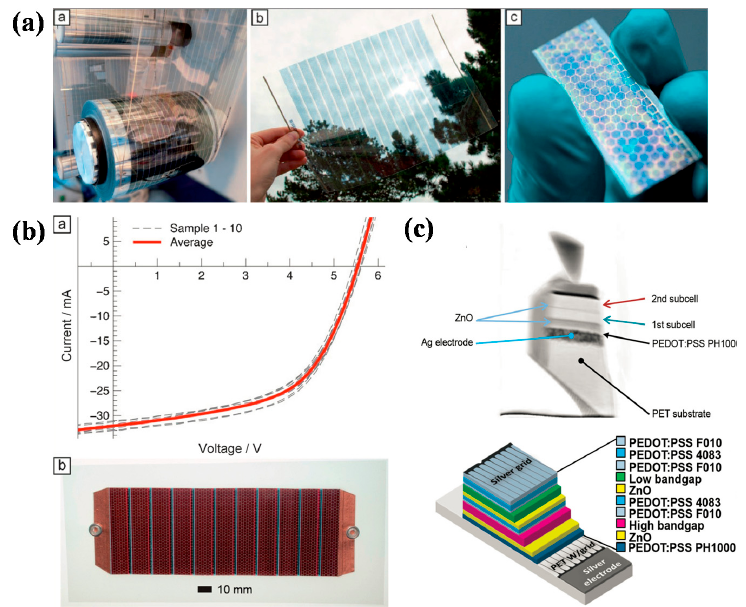
Figure 10. ( a ) Hundreds of meters of flextrode substrate (PET) ready for further R2R processing, flextrode substrate with 16 individual electrode stripes and mall flextrode cut-out suitable for OPV manufacturing using spin coating. ( b ) I–V curves (dashed lines) of ten randomly selected OPV modules containing eleven serial connected cells. The red line illustrates the average I–V curve.